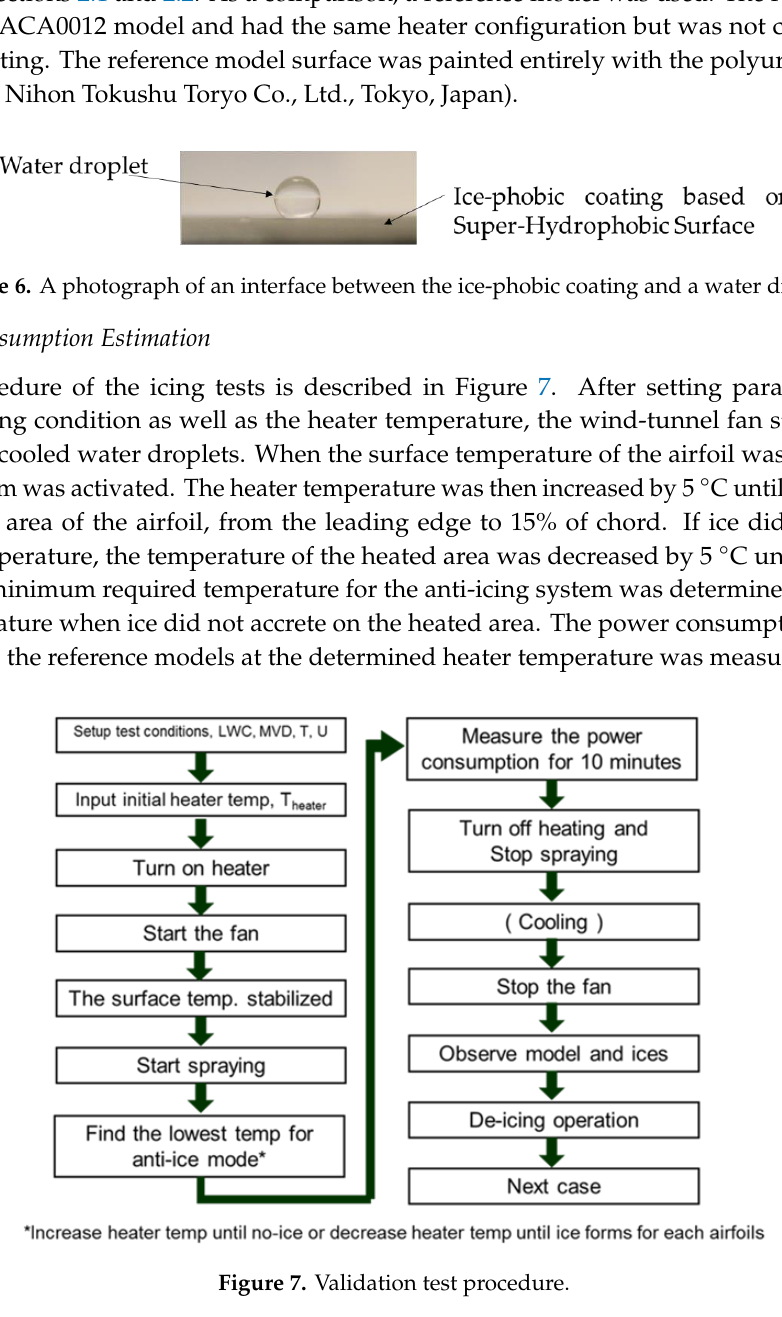
Figure 7. Validation test procedure.